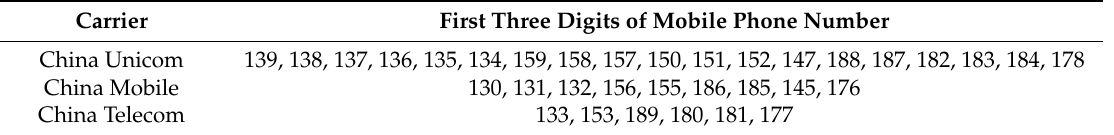
Table 2. Distribution of the first three digits of mobile phone number of the three carriers. Carrier